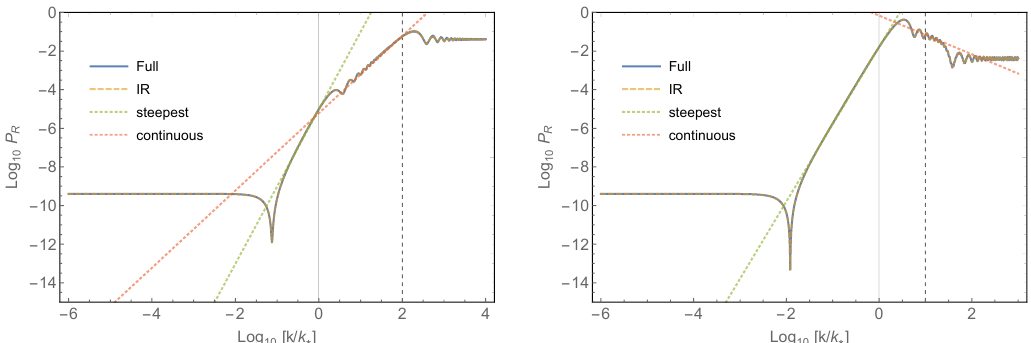
Figure 4 . The power spectrum P R given by (3.5) with H k = 10 − 5 in Planck unit from the phases of slow-roll (Phase 1) to negative-constant-rate (Phase 2) with δ 2 = − 2 (left panel) and δ 2 = − 3 . 5 (right panel). The dashed-vertical line is k = k ∗∗ , and for k > k ∗∗ a secondary slow-roll phase δ 3 = 0 is used in Phase 3. The late-time (IR) expansions of the power spectrum (3.6) in terms of the dashed lines are in well agreement with the full expression (3.5) in solid